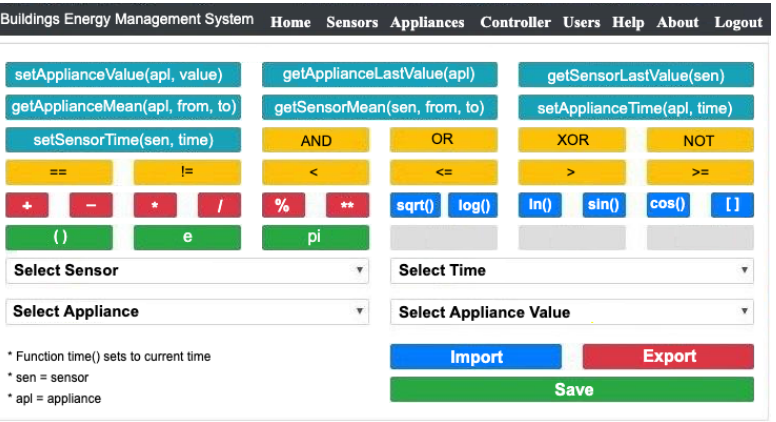
Figure 4. The administration section.